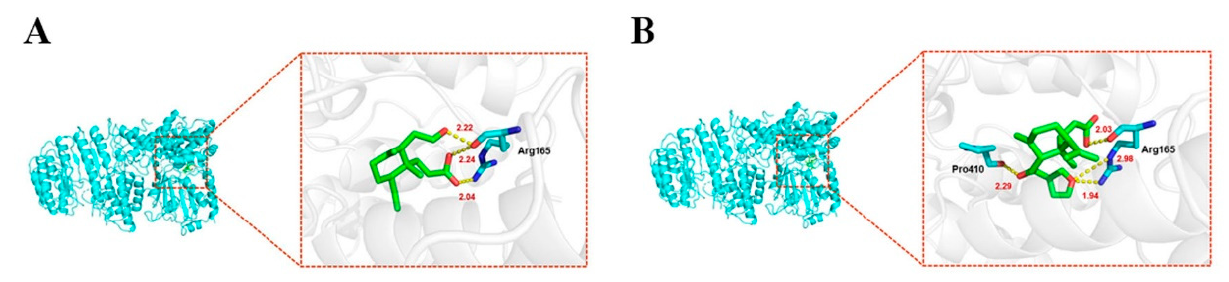
Figure 10. Docking and binding pattern of compounds 1 ( A ) and 2 ( B ) with into NLRP3 active site.